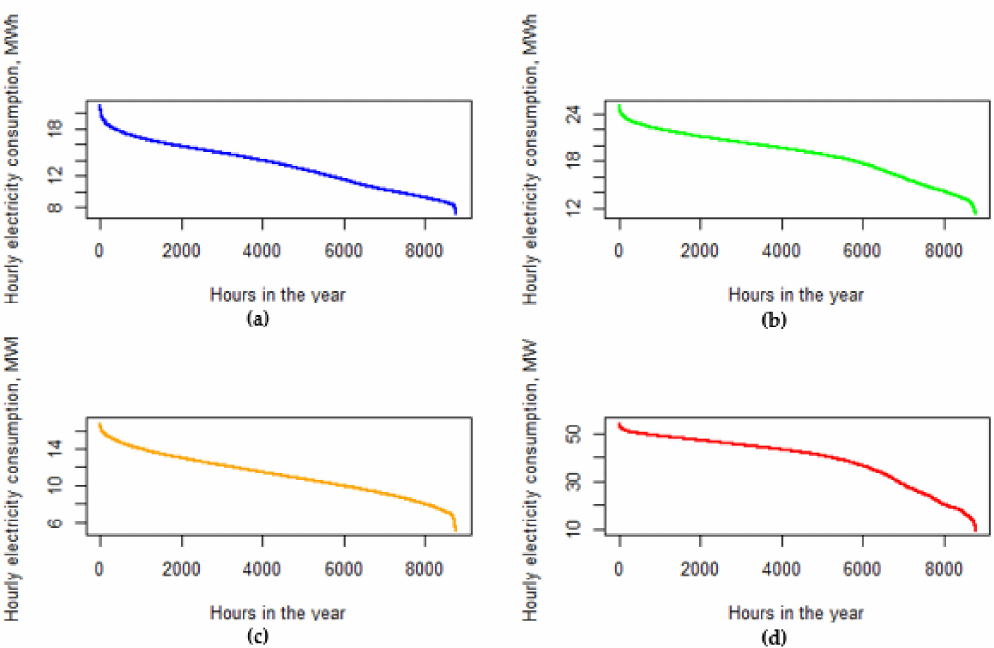
Figure 4. Ordered values of hourly energy consumption for the analyzed case study: ( a ) M1, ( b ) M2, ( c ) M3 and ( d ) M4. Source: own study.